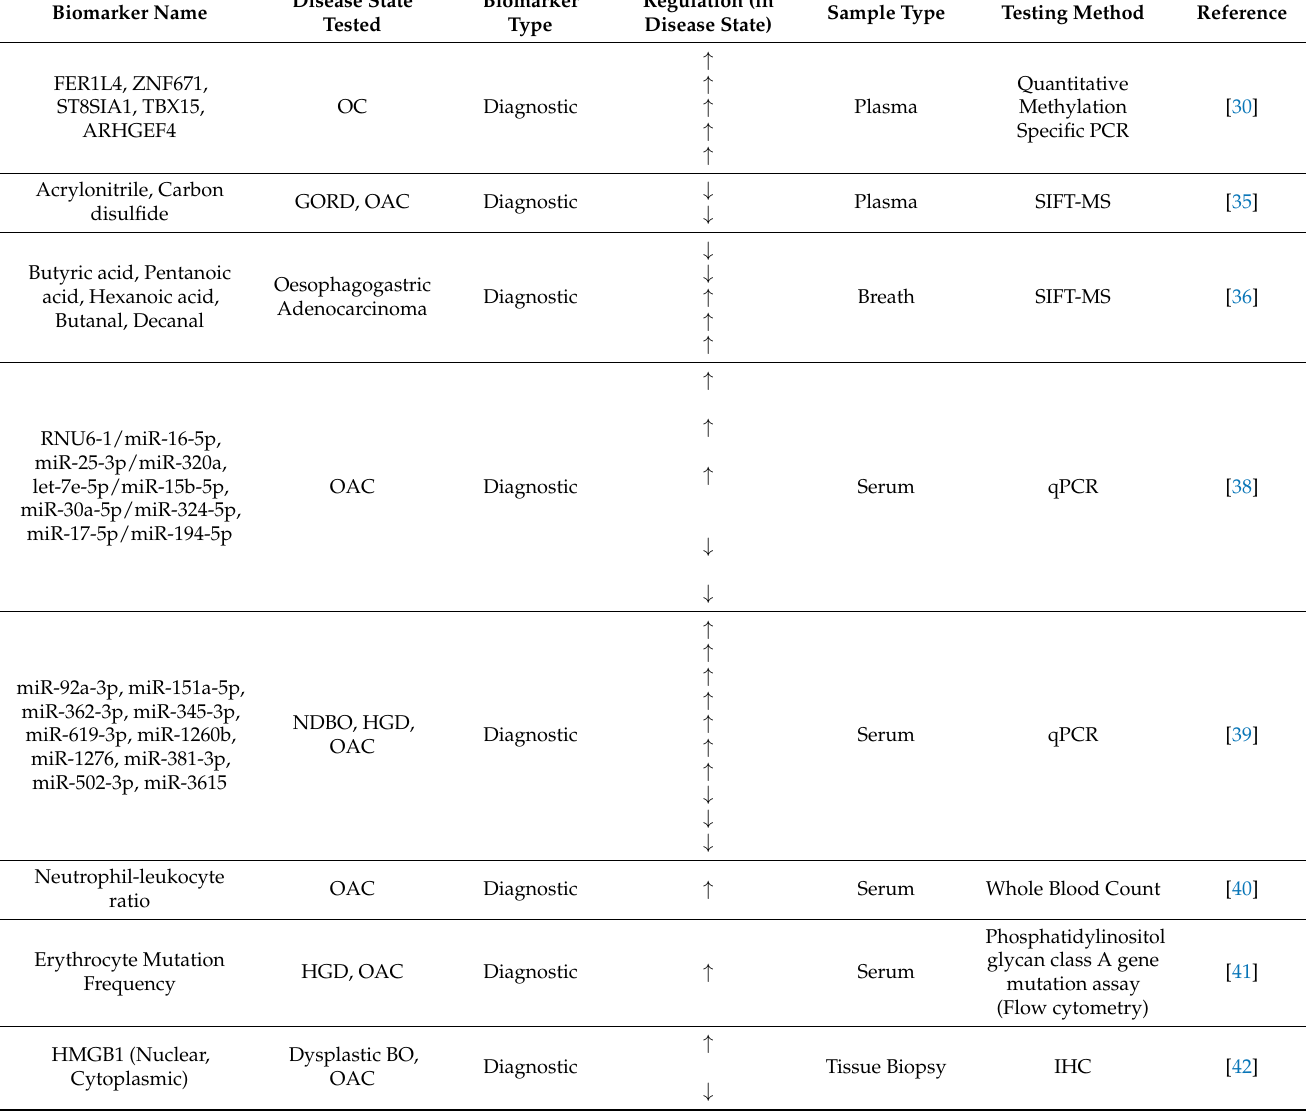
Table 2. Summary table of BO and OAC/OC diagnostic